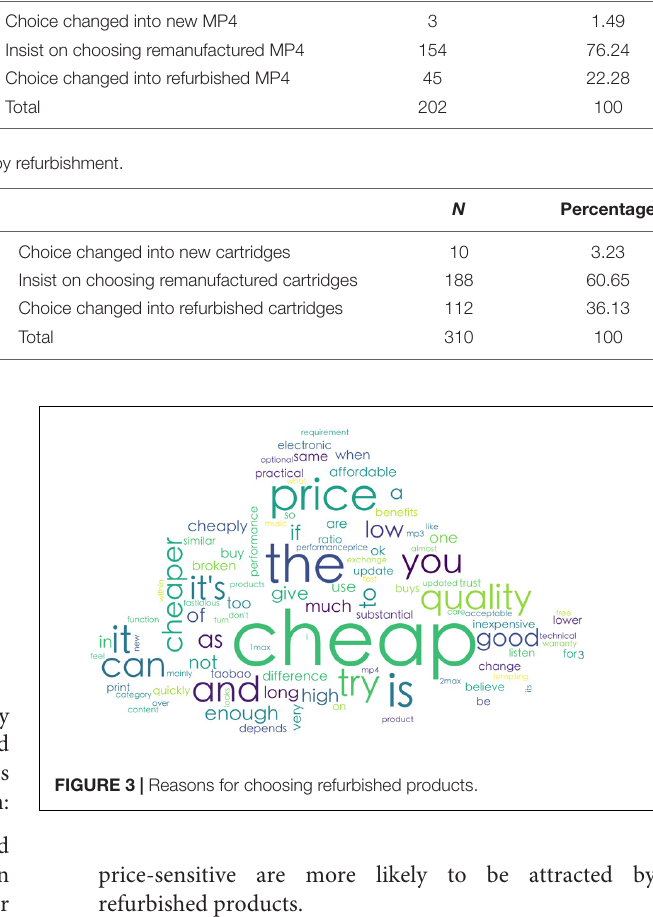
TABLE 5a | Statistics of selection change of remanufactured MP4 caused by refurbishment. Change of choice